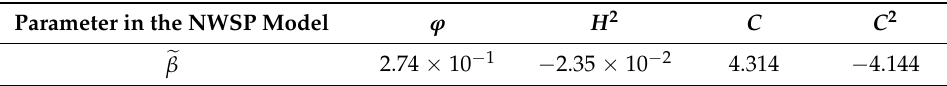
Table 5. Standardized coefficients (cid:101) β of the different